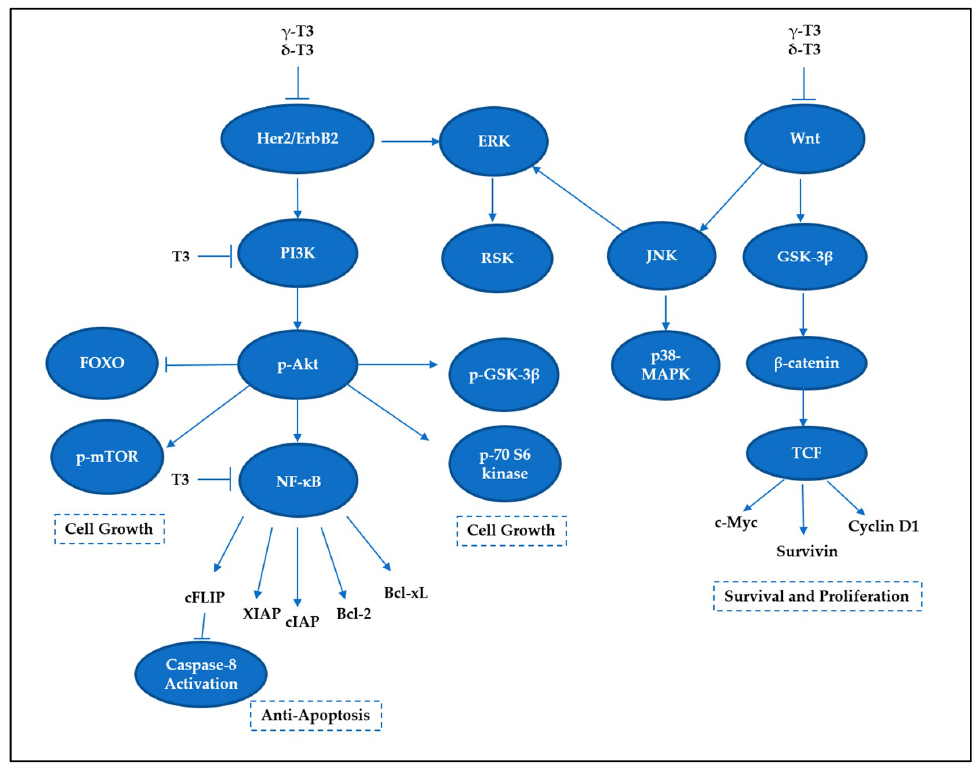
Figure 6. Tocotrienols suppress cell survival signaling pathways in cancers.